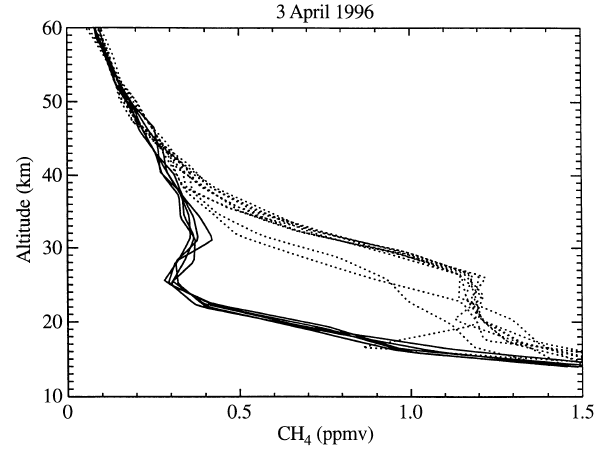
Fig. 17. HALOE measurements of CH 4 vertical profiles at 60 (cid:14) N on April 7, 1993. Measurements clearly inside the polar vortex are shown as solid lines , those outside and at the vortex edge by dotted